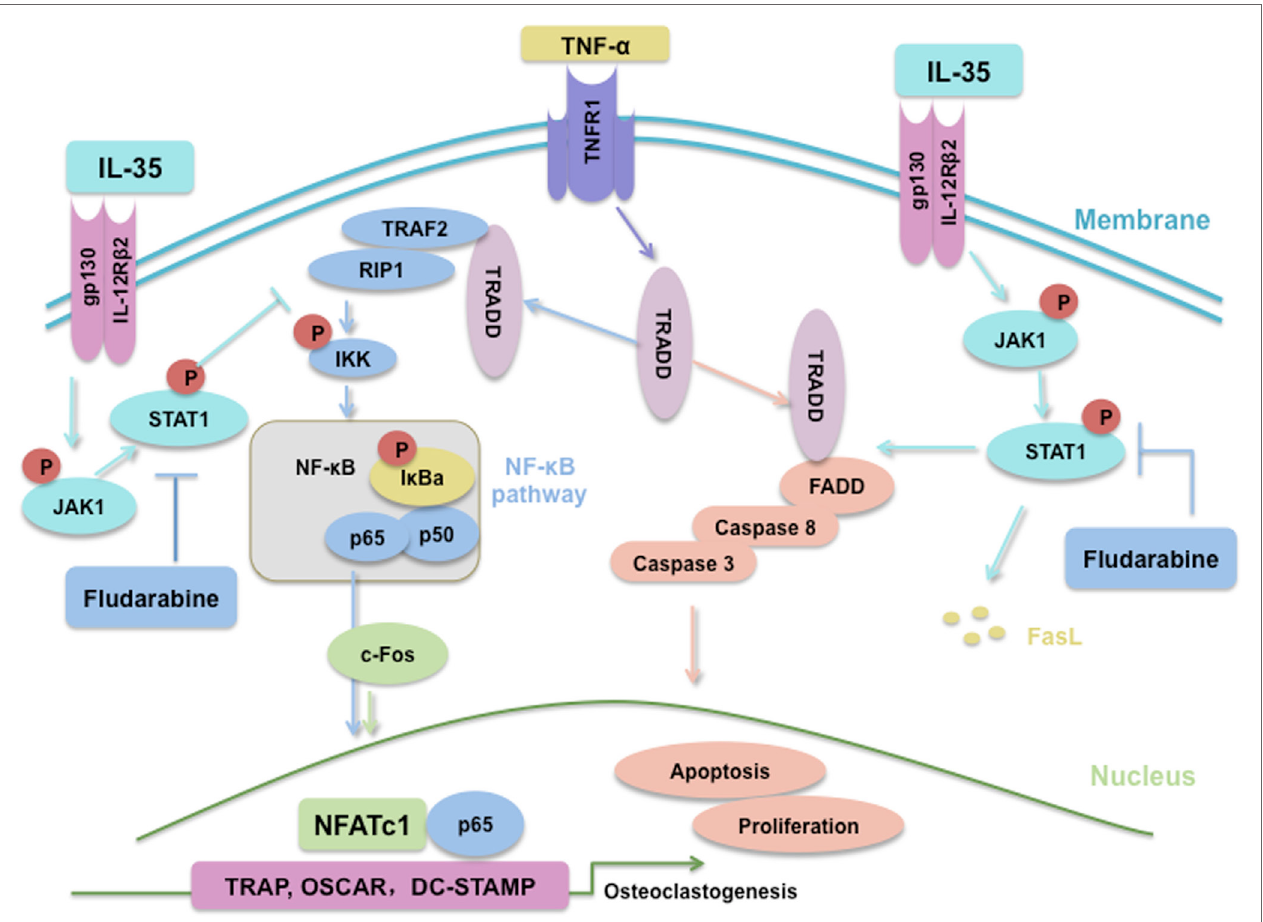
FigUre 8 | Schematic of interleukin 35 shifting the activating pathway of TNF- α from TNF receptor-associated death domain (TRADD)-TARF2/RIP1-NF- κ B to TRADD-Fas-associated death domain-caspase3 to promote apoptosis of osteoclasts.